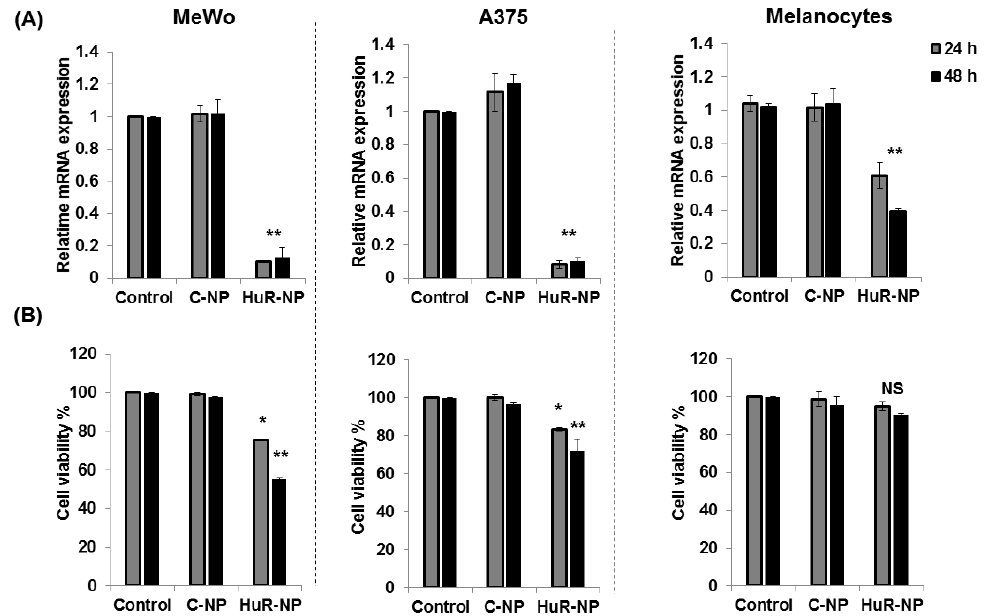
Figure 1. Effect of human antigen R (HuR)-nanoparticle (NP) treatment on HuR mRNA and cell viability . ( A ) HuR mRNA level and ( B ) cell viability was determined in human melanoma (MeWo, A375) cells and melanocytes treated with control siRNA-NP (C-NP) or HuR-NP (100 nM) for 24 h and 48 h. Untreated cells served as control. Error bar denotes SD; NS not significant; * p < 0.05; ** p < 0.01.